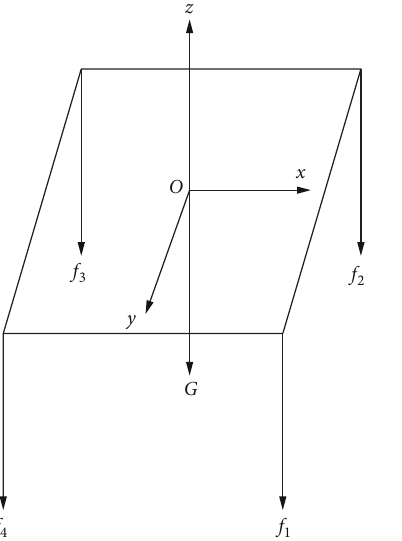
F IGURE 6: Schematic diagram of hanging